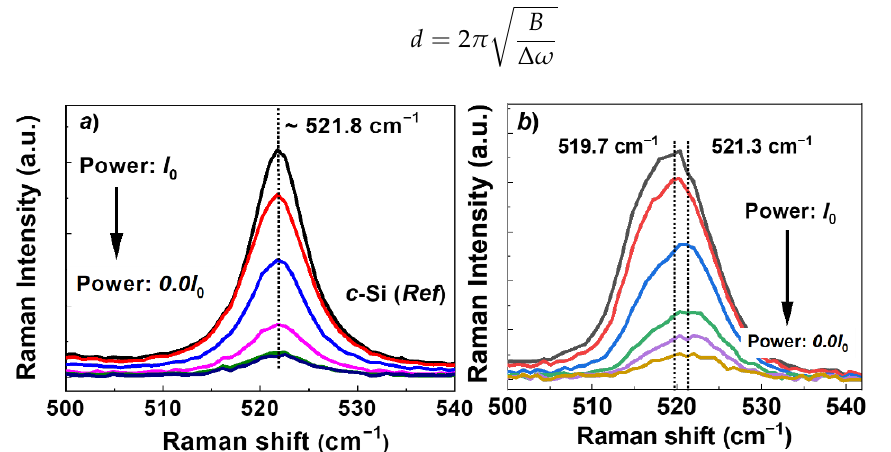
Figure 8. Excitation power dependence Raman spectra. ( a ) Crystalline reference silicon. ( b ) Electrodeposited Si-layer obtained with applying low potential .